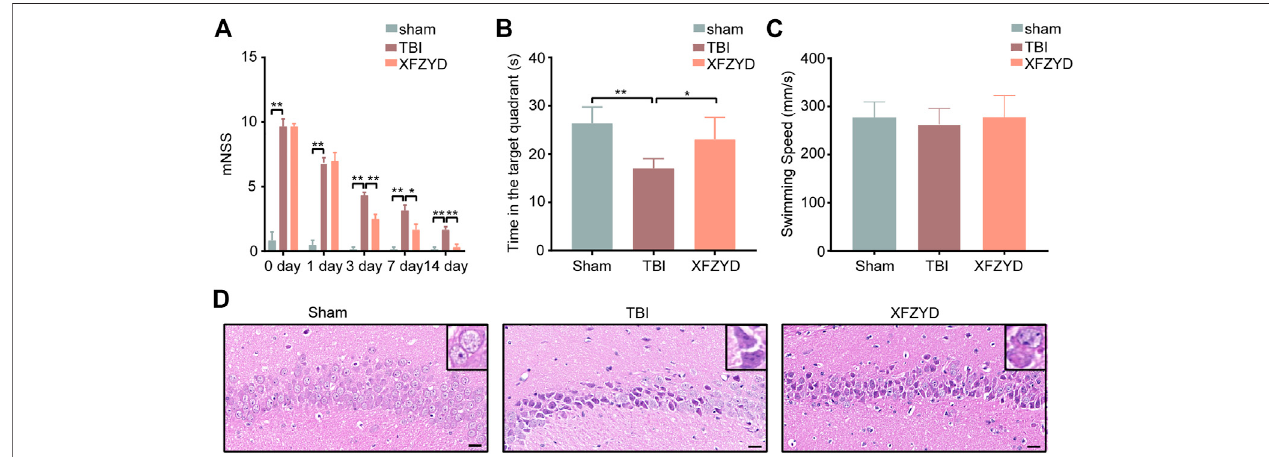
FIGURE2| EffectsofXFZYDonTBI. (A) ThemNSSofsham,TBI,andXFZYDgroupsonpost-injury,1stday,3rdday,7thday,and14thday.(0daypresentspost- injury) (B) Timeinthetargetquadrantofsham,TBI,andXFZYDgroups. (C) Theswimmingspeedofsham,TBI,andXFZYDgroups. (D) HEstaining(400x)inCA1region